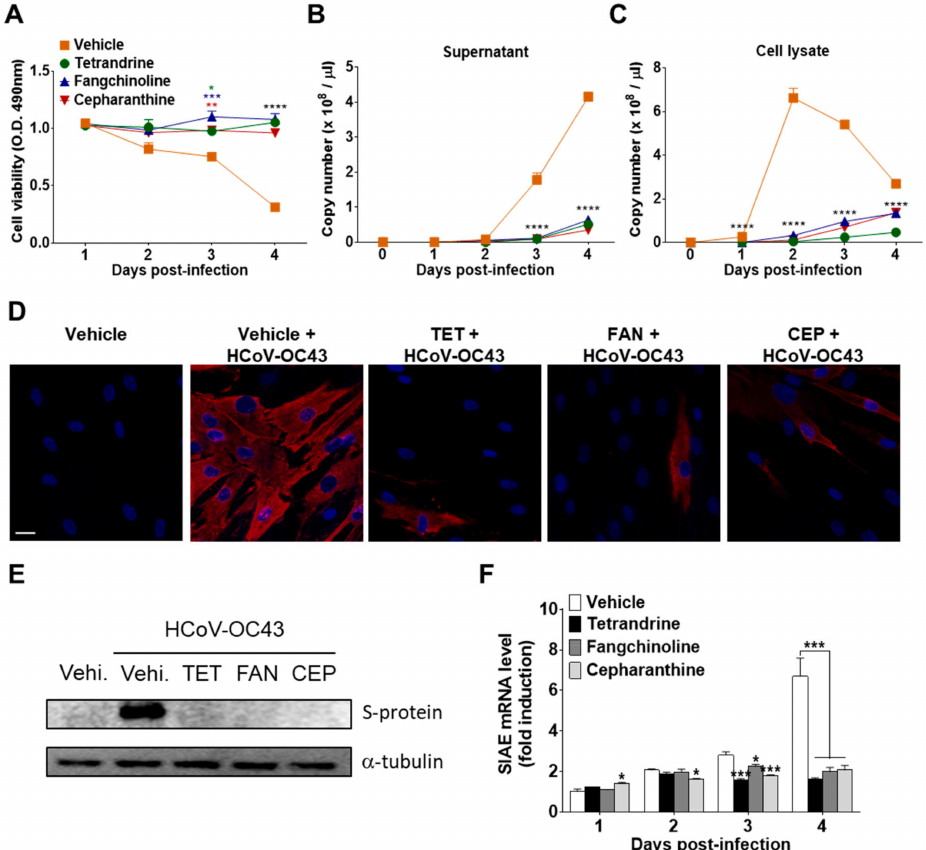
Figure 5. Inhibition of HCoV-OC43 copy number, nucleoprotein (N) and spike glycoprotein (S) protein expression, and sialic acid acetylesterase (SIAE) mRNA levels in MRC-5 cells by TET, FAN, and CEP. HCoV-OC43-infected MRC-5 cells were treated with 5 µ M TET, FAN, and CEP (Vehicle 0.025% DMSO). The culture supernatant and cell lysates were harvested at the designated times. ( A ) Cell viability was assessed using the MTS assay at 1, 2, 3, and 4 days post-infection ( B and C ). The RNA copy number of the HCoV-OC43 N protein released into the culture supernatant ( B ) and cell lysates ( C ) were examined by qRT-PCR. Viral RNA and total RNA were isolated from culture supernatants and the lysates of infected cells for quantification of HCoV-OC43 RNA levels. ( D ) Images were captured by fluorescence microscopy at two dpi. Immunofluorescence staining of the nucleus with 4 (cid:48) ,6-diamidino-2-phenylindole (DAPI) (blue) and HCoV-OC43 N protein (red). Scale bar = 50 µ M. ( E ) Immunoblot analysis of the cell lysates at two dpi. The S protein of HCoV-OC43 was detected with α -tubulin as a control. ( F ) SIAE mRNA levels of MRC-5 cells were analyzed at 1, 2, 3, and 4 dpi using qRT-PCR. β -Actin was used for data normalization. Data are presented as mean ± SEM of three independent experiments. * p < 0.05, ** p < 0.01, *** p < 0.001, and **** p < 0.0001 versus the vehicle group (one-way ANOVA plus Tukey’s multiple comparisons